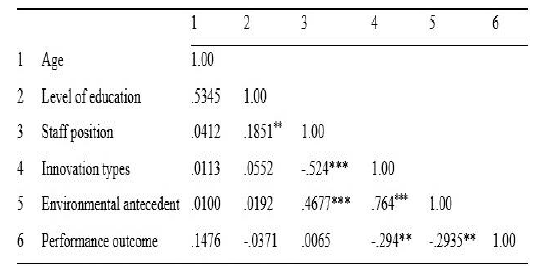
Table 5: Correlational Analysis